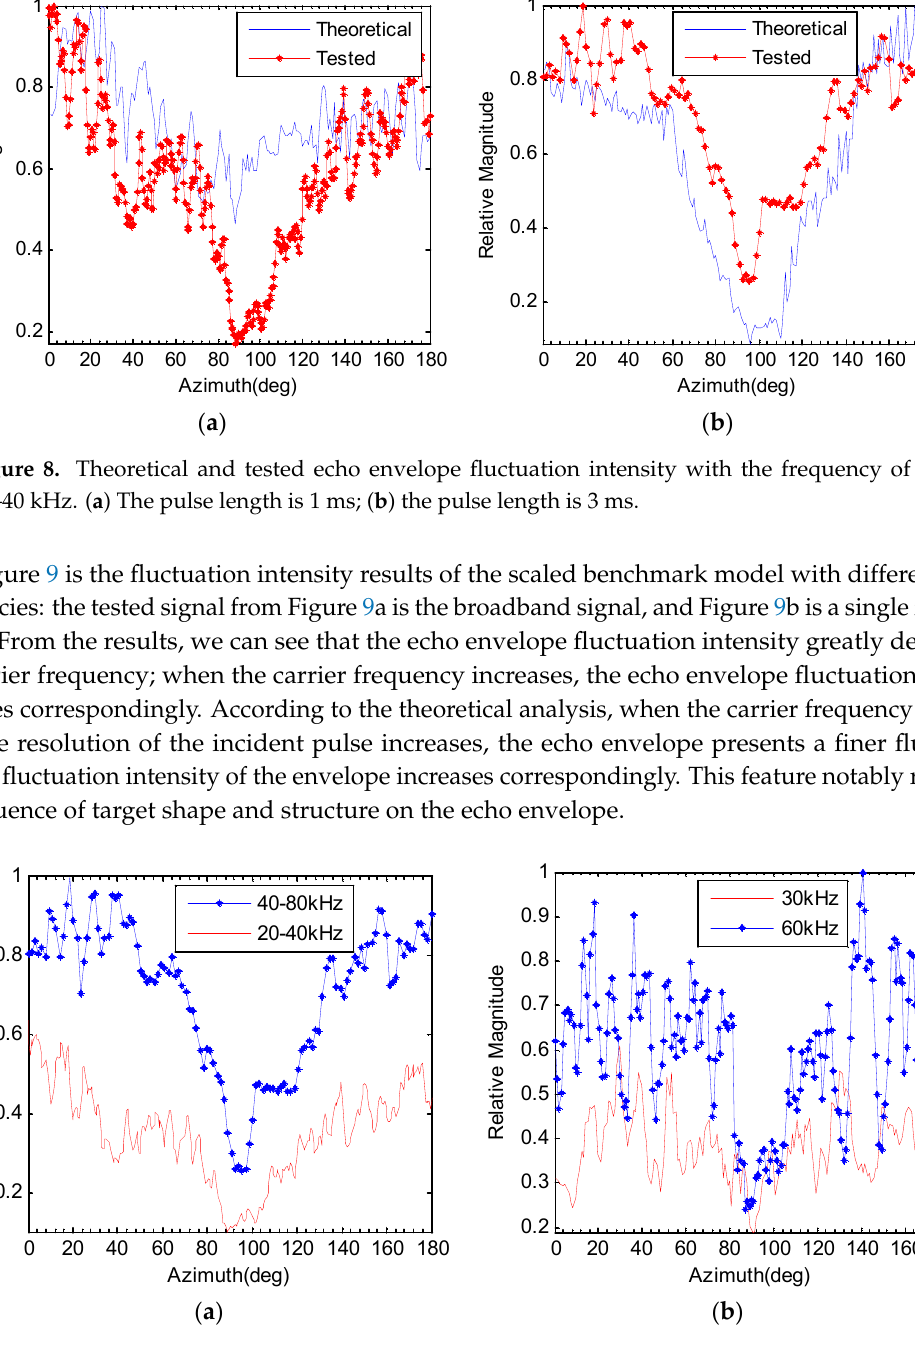
Figure 9. ( a ) Fluctuation intensity comparison of the wideband echo envelope with different frequencies, the pulse length is 3 ms; ( b ) fluctuation intensity comparison of the CW echo envelope with different frequencies, the pulse length is 3 ms.